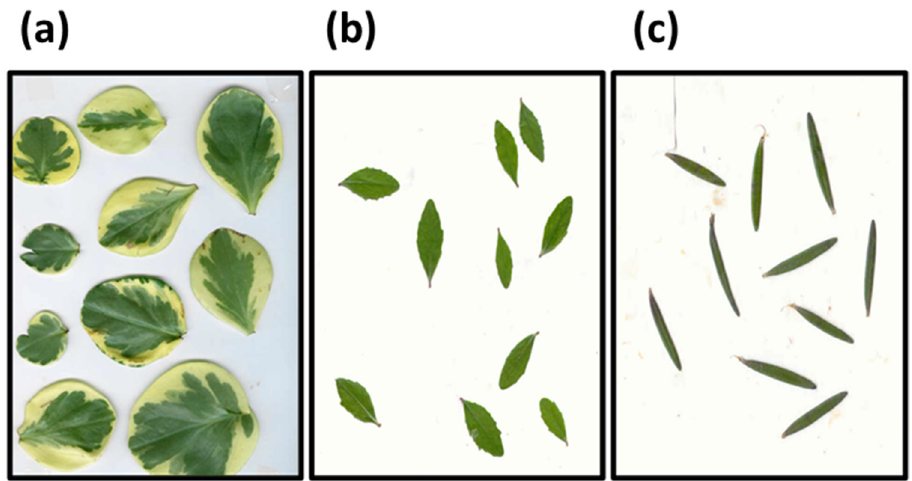
Figure 1. Leaf scanning in the different ornamental species studied: ( a ) baby rubber ( Peperomia obtusifolia L.), ( b ) confetti tree ( Maythenus senegalensis Lam. Exell), and ( c ) rosemary ( Rosmarinus officinalis L).